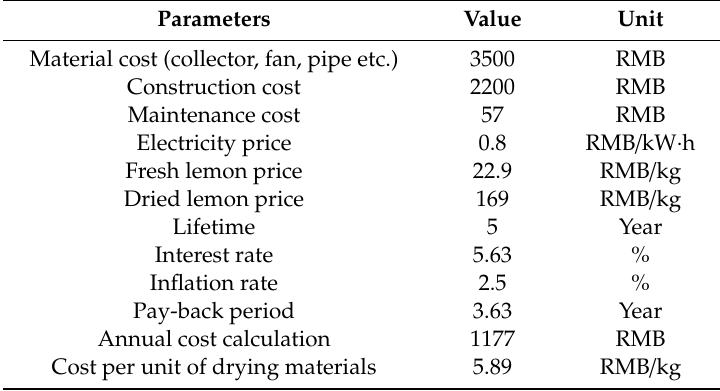
Table 7. The economic analysis results of the hybrid solar